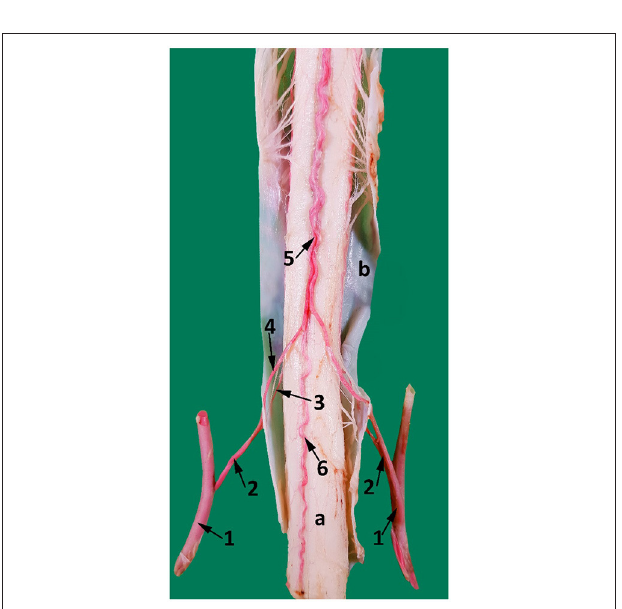
FIGURE 8 | A ventral view of the spinal cord at the level between the third and the fourth cervical vertebrae. 1, vertebral artery; 2, spinal branch located between C3 and C4; 3, lateral spinal branch; 4, ventral spinal branch; 5, paired ventral spinal arteries that fuse to form a single ventral spinal artery cranially; 6. single ventral spinal artery; a, spinal cord; b, dura